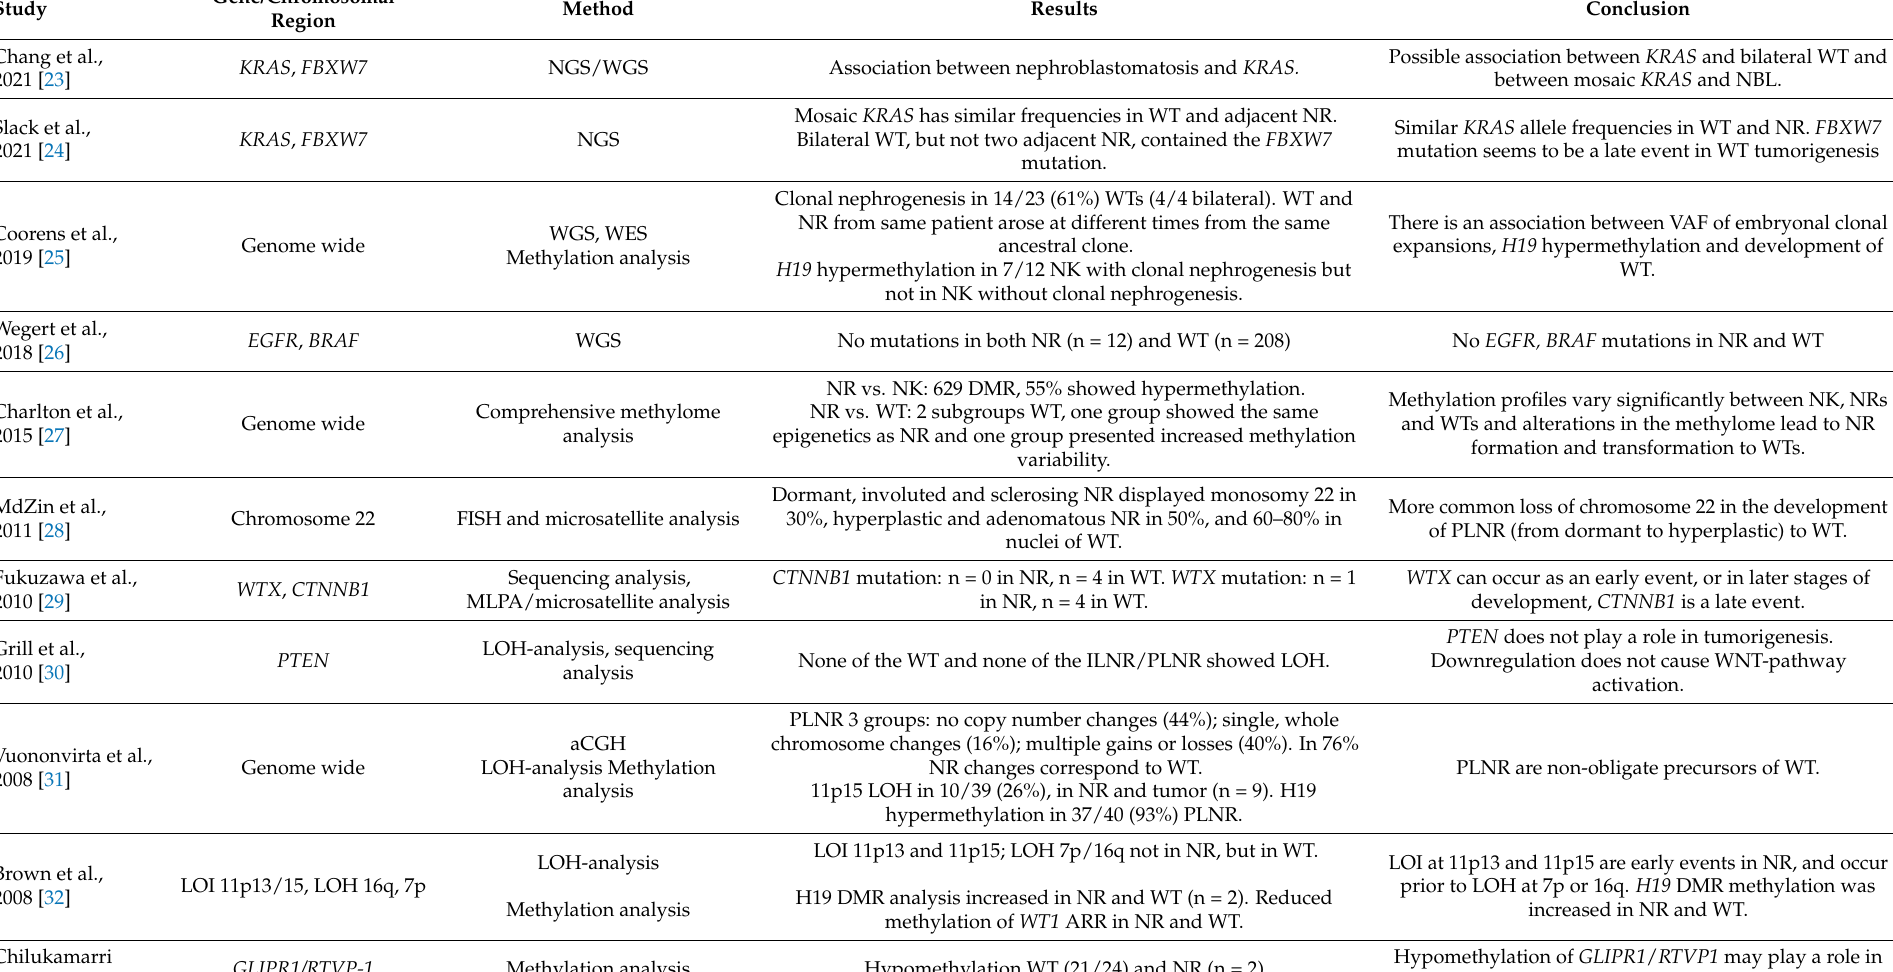
Table 2. Genetic changes in